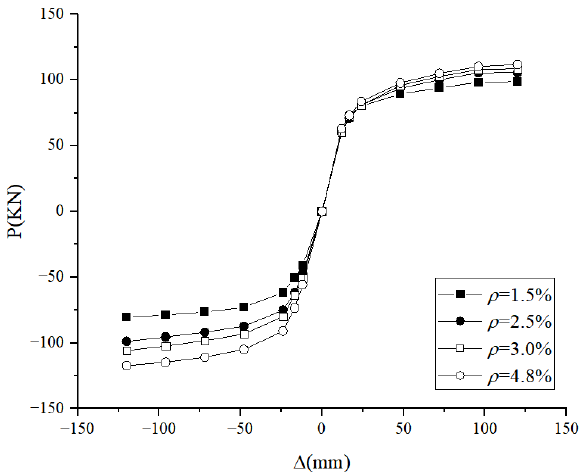
Figure 20. Ratio of longitudinal rebar in concrete slab.